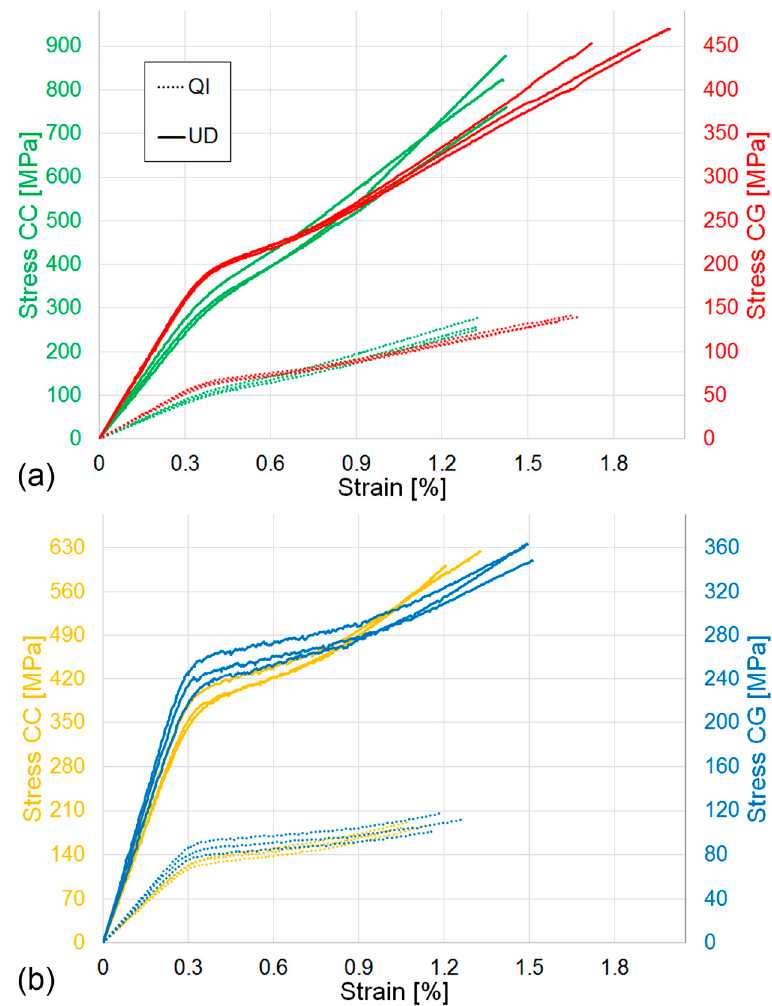
Figure 7. Tensile stress-stain curves for pseudo-ductile ADFRCs: ( a ) 20%HMC / 80%HSC (CC) and 20%HMC / 80%EG (CG); ( b ) 50%HMC / 50%HSC (CC) and 40%HMC / 60%EG (CG).